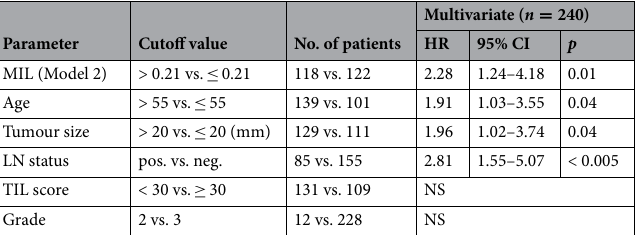
Table 5. Multivariate analysis for breast cancer specific survival of TNBC patients for Model 2 output. NS not significant.